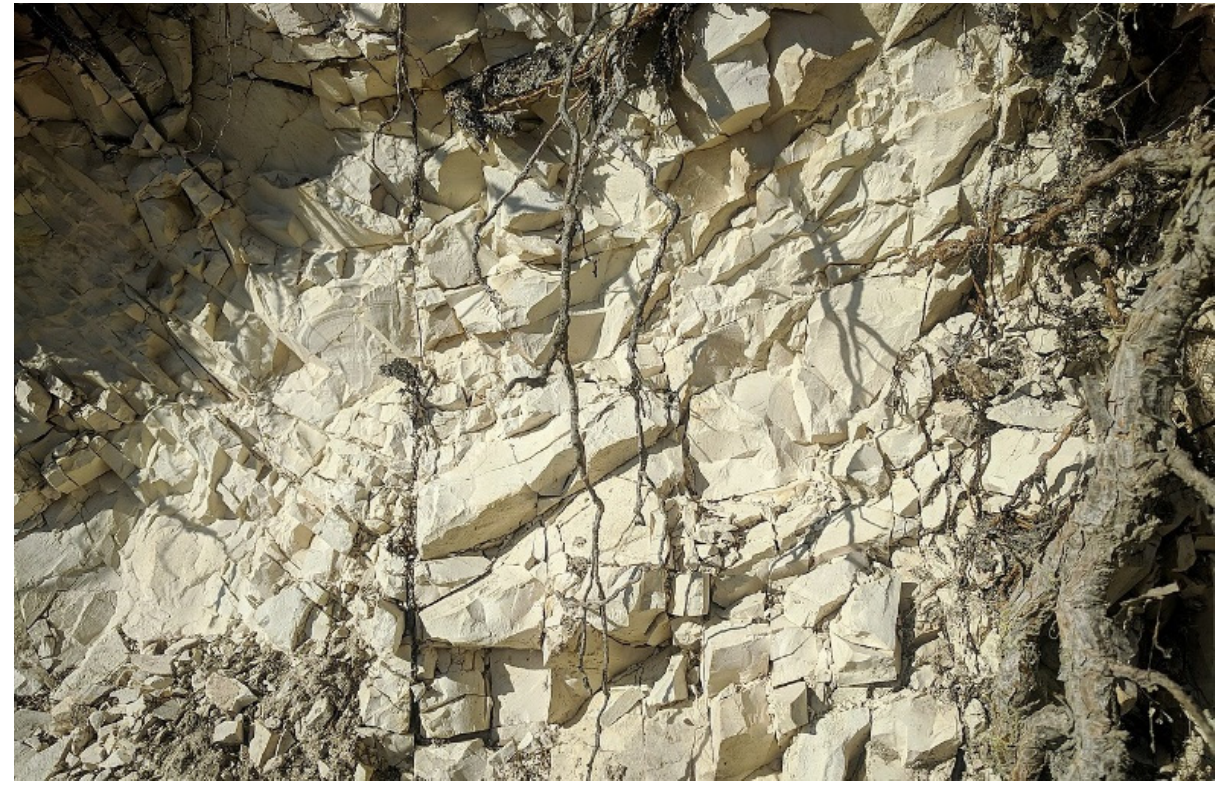
Figure 3. A limestone deposit in the Dinaric Alps near Sinj, Croatia [29] .